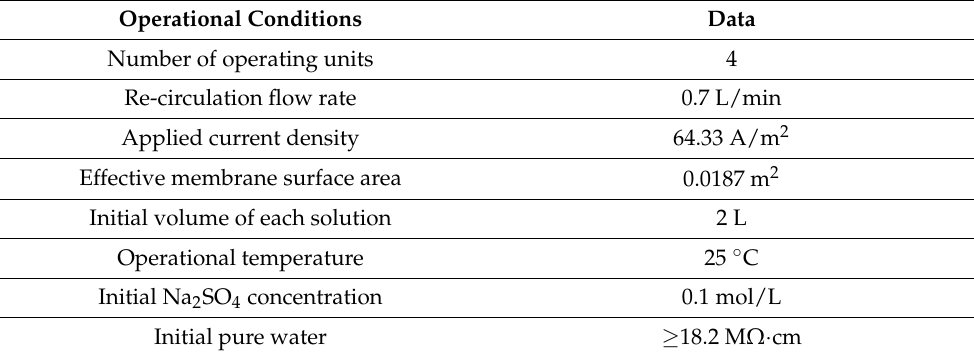
Table 3. Applied operational conditions during electrochemical deacidification